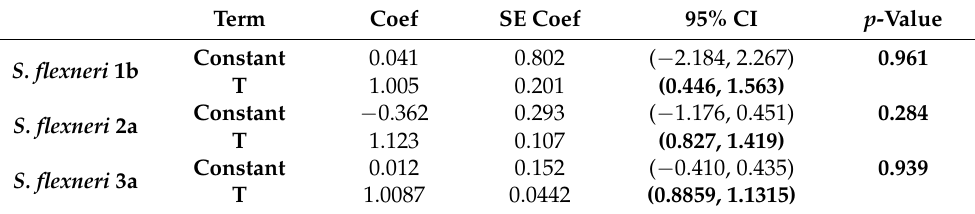
Table 2. Coefficients of the regression analysis for each of the three S. flexneri serotypes tested. The Constant term represents the intercept of the regression line whereas the T term represents the slope of the regression